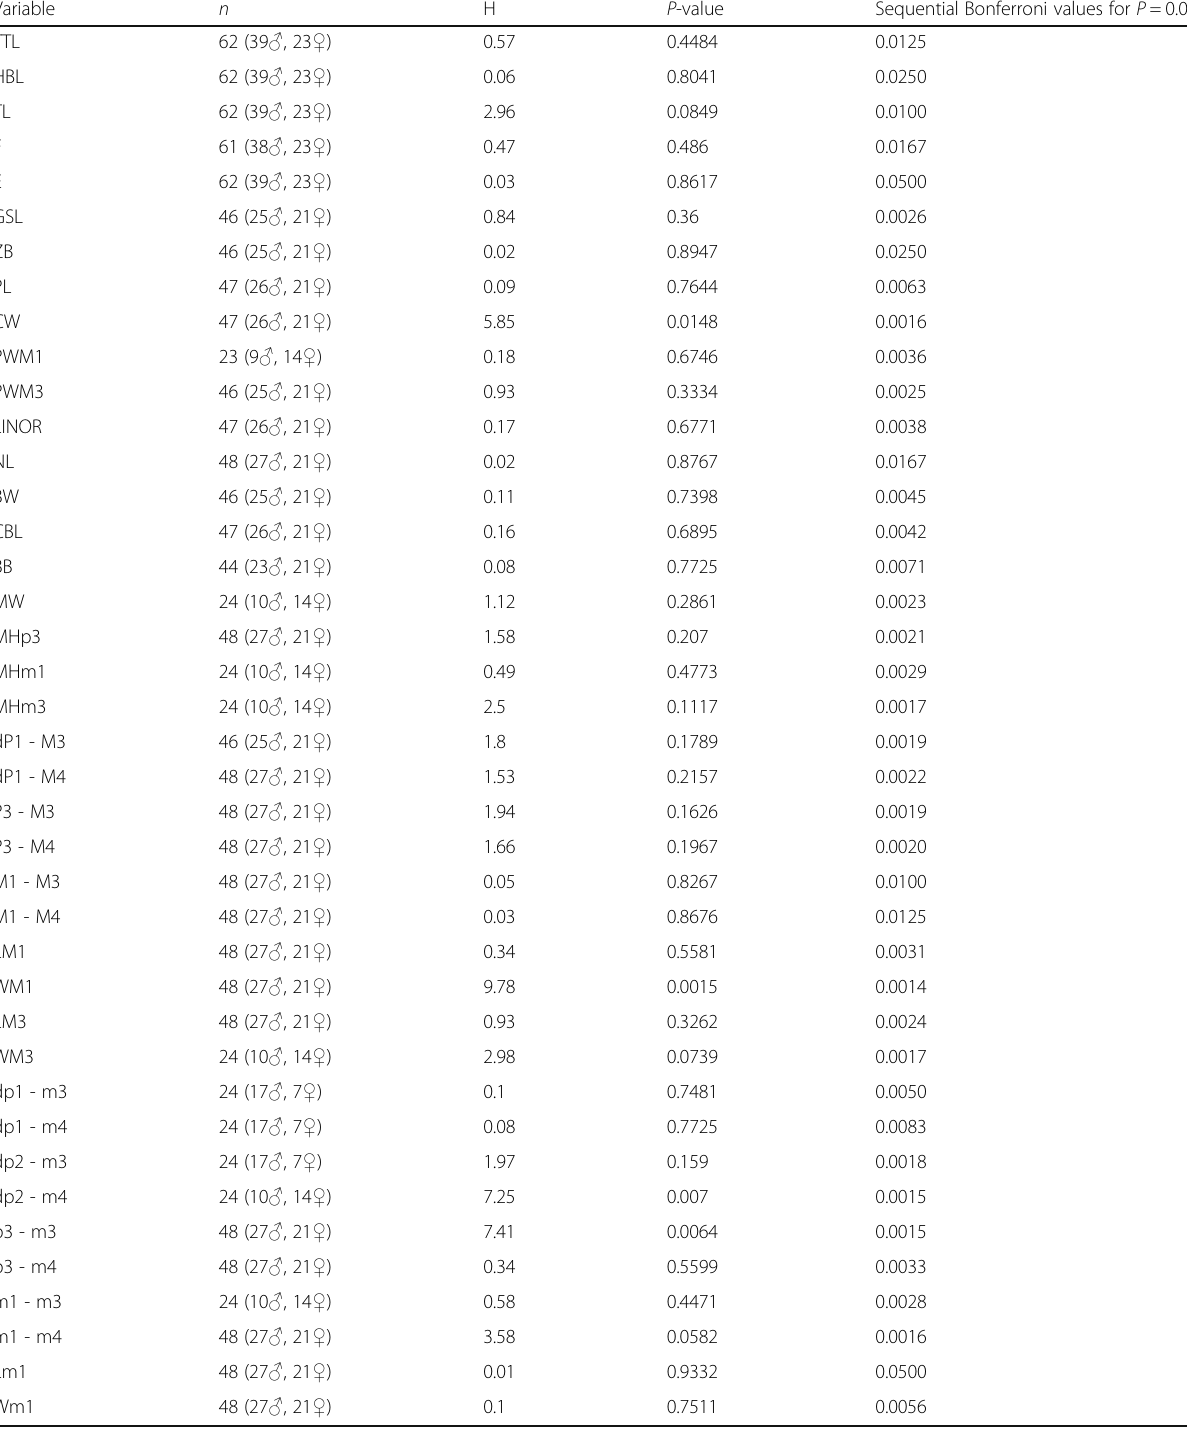
Table 4 Results of a non-parametric Kruskal – Wallis analysis of variance (ANOVA), calculated from Mosimann ’ s variables for differences between males and females of Rhyncholestes raphanurus Osgood, with specimens from all continental localities (i.e., excluding Chiloé Island). The number of analyzed specimens ( n ) and specimens by sex (between brackets) are indicated for each measurement. Asterisks mark significant differences (if existent) for sequential Bonferroni-corrected values, following Rice [39].